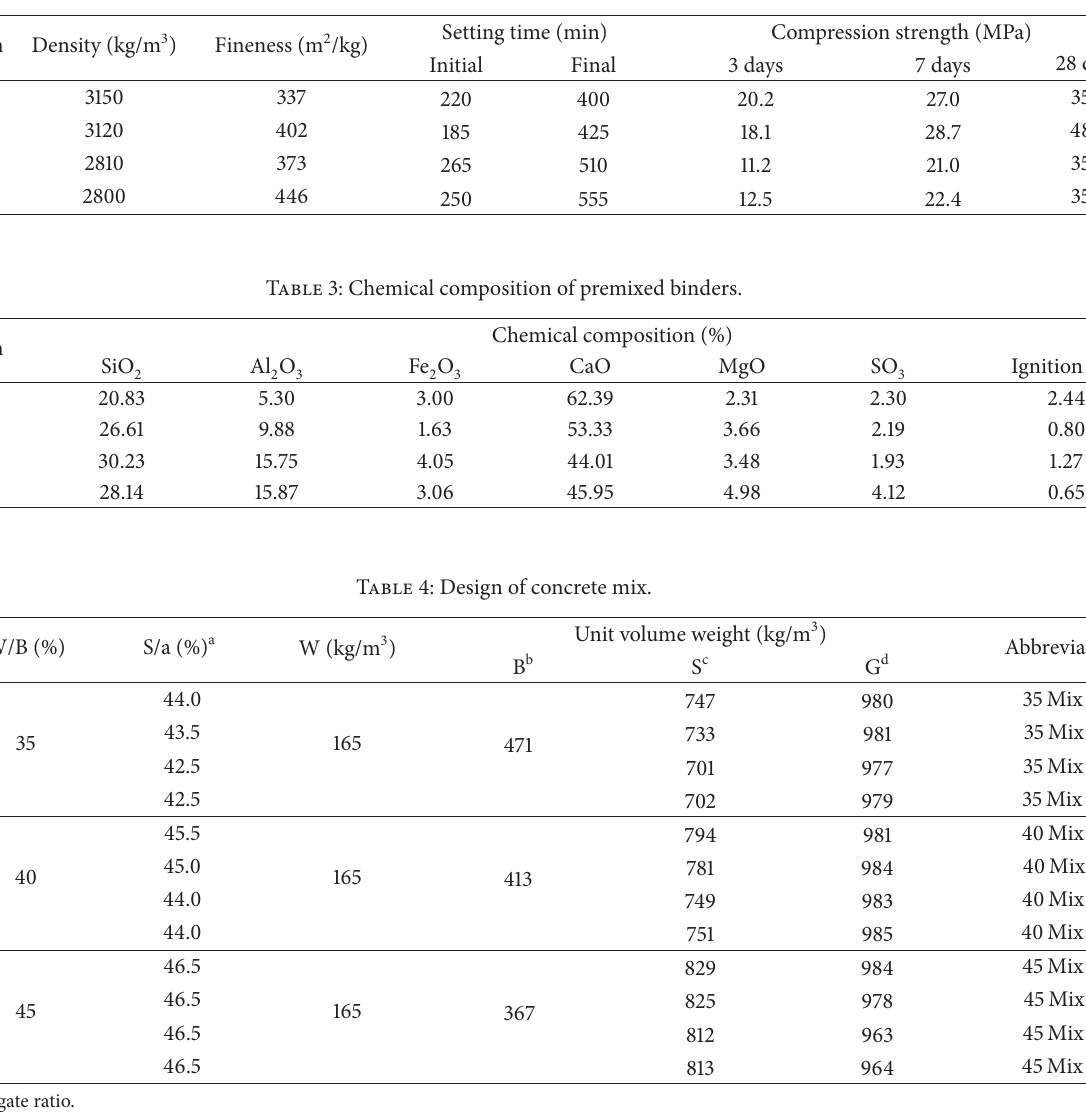
Table 2: Physical properties of premixed binders.